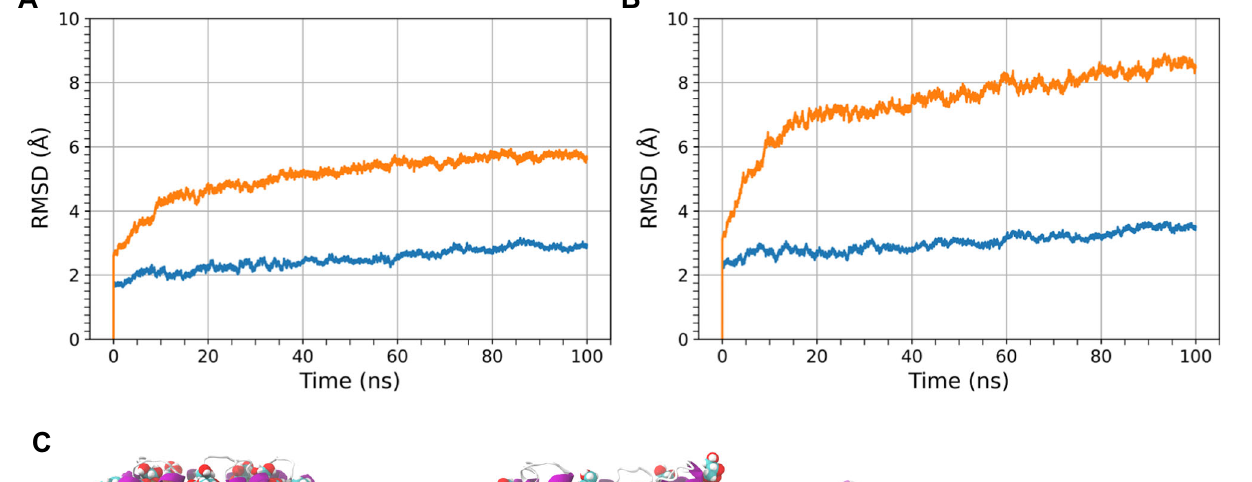
without phospholipids — orange). C The initial F-pilus structure including phos- pholipids is shown atthe left. The centre image shows the structure of the F-pilus with phospholipids from the end of the 100ns equilibrium simulation. The rightmost image shows the structure of the F-pilus without phospholipids from the end of the 100ns equilibrium simulation. Source data are provided as a Source data fi